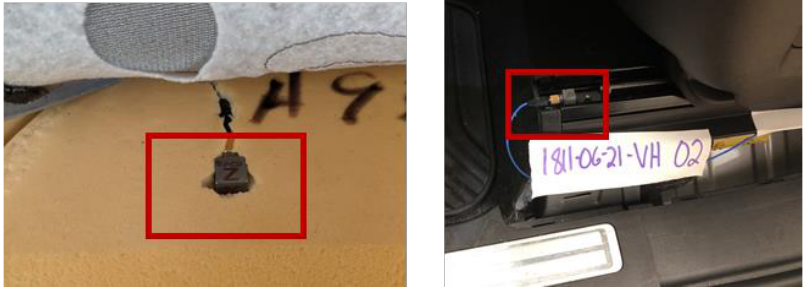
Figure 4. Accelerometers instrumentation for field test. Accelerometer in the cushion ( left ); accelerometer on the floor-mounted seat track ( right ).